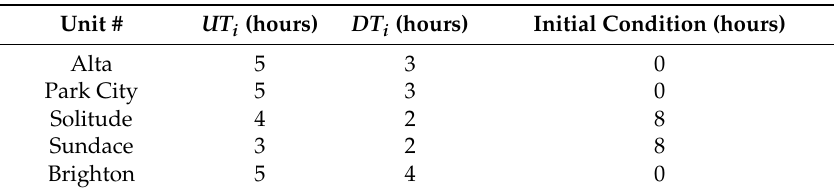
Table 1. Minimum up ( UT ) and down ( DT ) times.